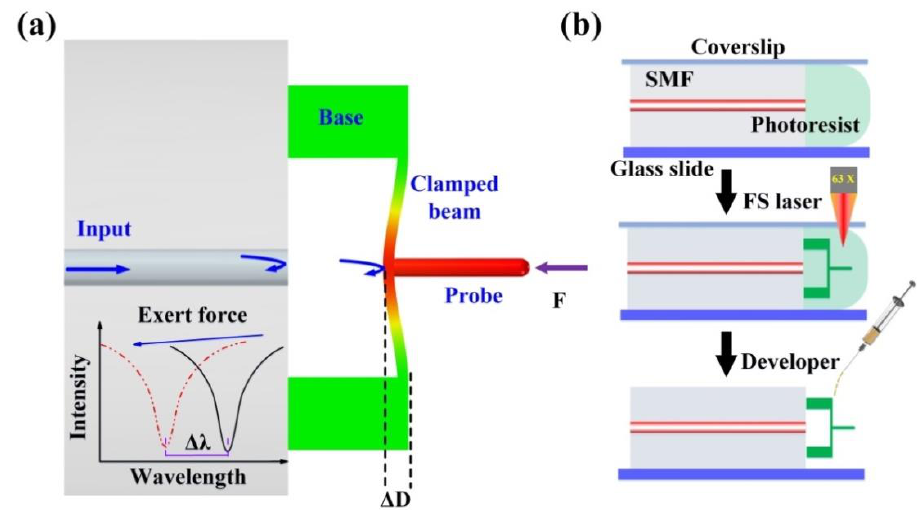
Figure 2. Sensing schematic diagram of the proposed sensor. ( a ) Simulation results for the device under an applied external force, ( b ) FTMS fabrication process.